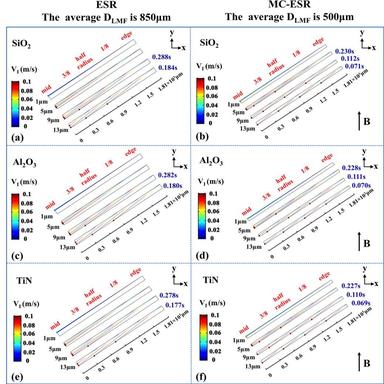
Simulation results of the motion trajectory of inclusions (in different size, type or density, release position of MLI) in LMF in this study, (a) SiO2 in ESR, (b) SiO2 in MC-ESR, (c) Al2O3 in ESR, (d) Al2O3 in MC-ESR, (e) TiN in ESR, (f) TiN in MC-ESR, respectively.